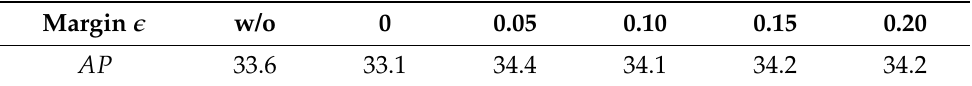
Table 3. Ablation study of our query update mechanism; w/o refers to results without this up- date